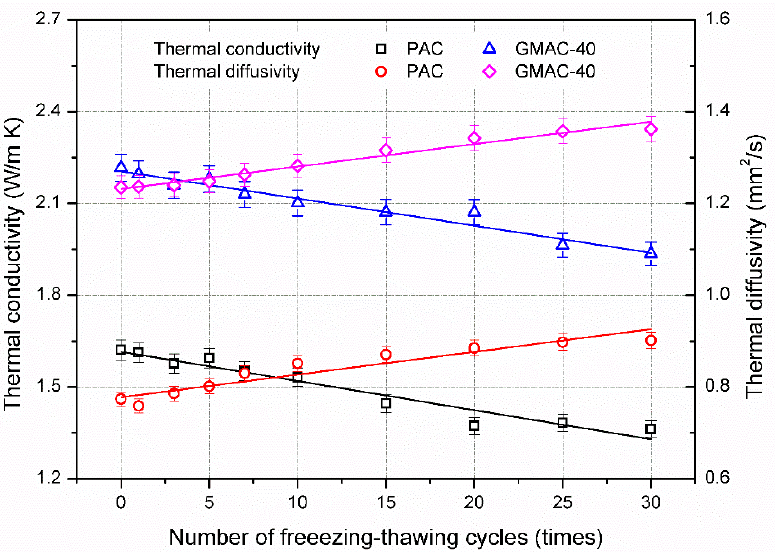
Figure 8. Thermal conductivity and diffusivity of asphalt mixtures after freezing–thawing cycles.